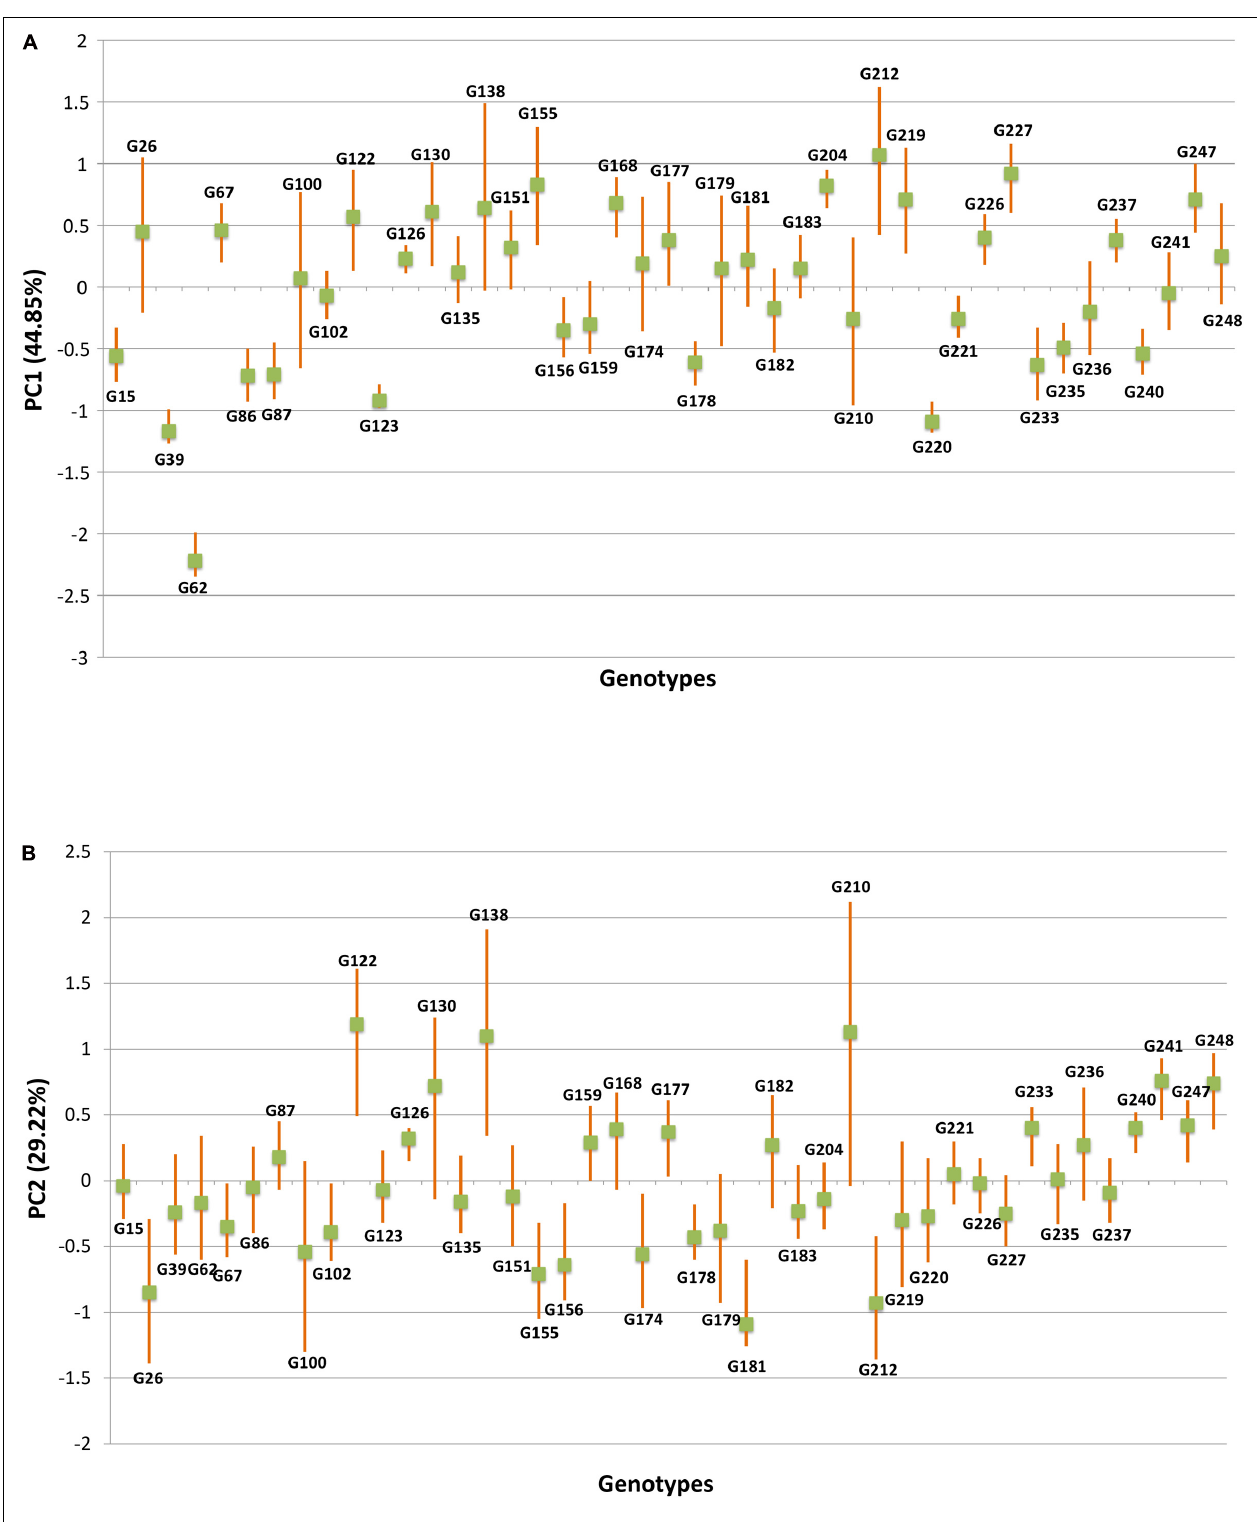
FIGURE 7 | The fitted principal components (PCs) versus genotype based on foliar blast disease score along with upper and lower limit values, produced by bootstrap analysis over 10,000 times at 95% bias-corrected and accelerated bootstrap (BCa) confidence limits (CLs). (A) Principal component analysis (PCA) score values on PC1 versus genotype. (B) PCA score values on PC2 versus